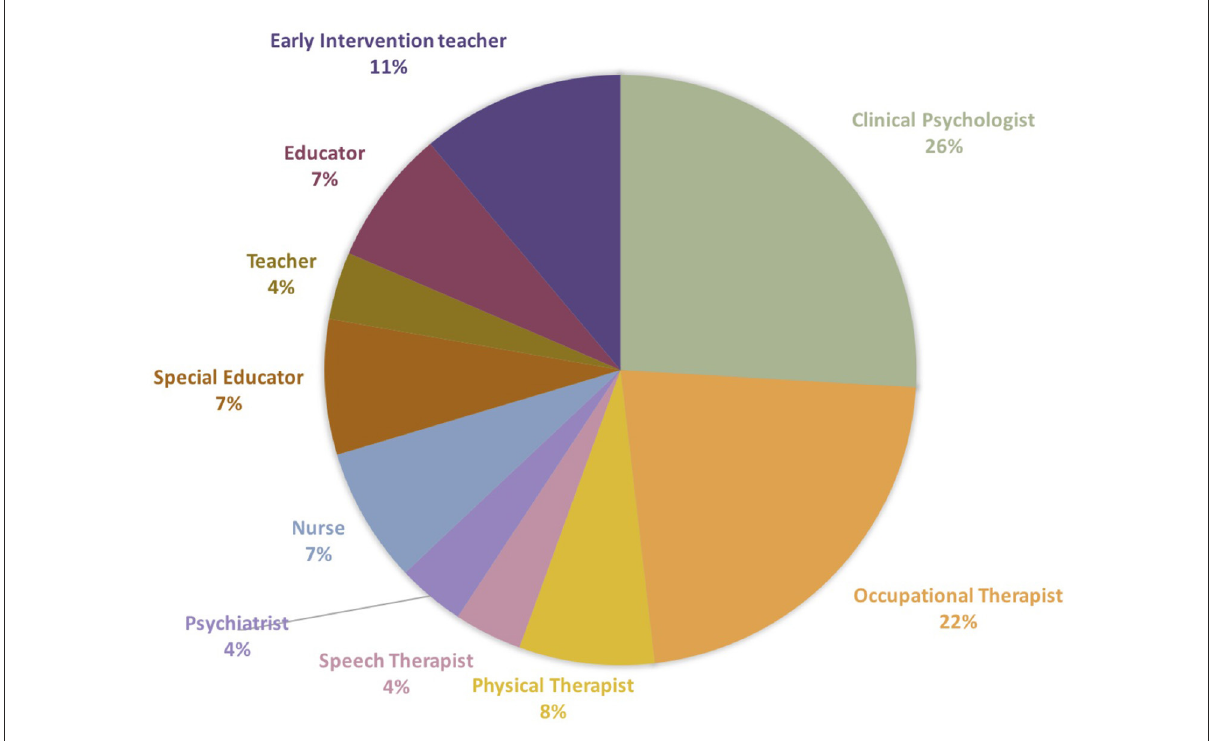
FIGURE2 Types of the profession of facilitator at the promotional stage. The facilitators were clinical psychologists, occupational therapists, physiotherapists, speech therapists, special educators, educators, psychiatrists, early intervention teachers, and nurses.